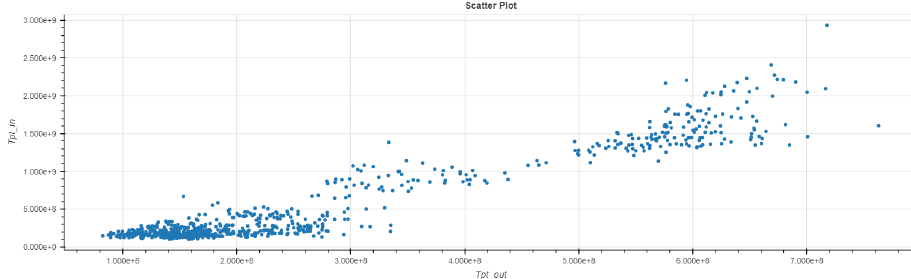
Figure 17. The throughput correlation. This plot indicates the linear distribution of predicted values. The summary of the SARIMA model using the subscriber data is presented in Figure